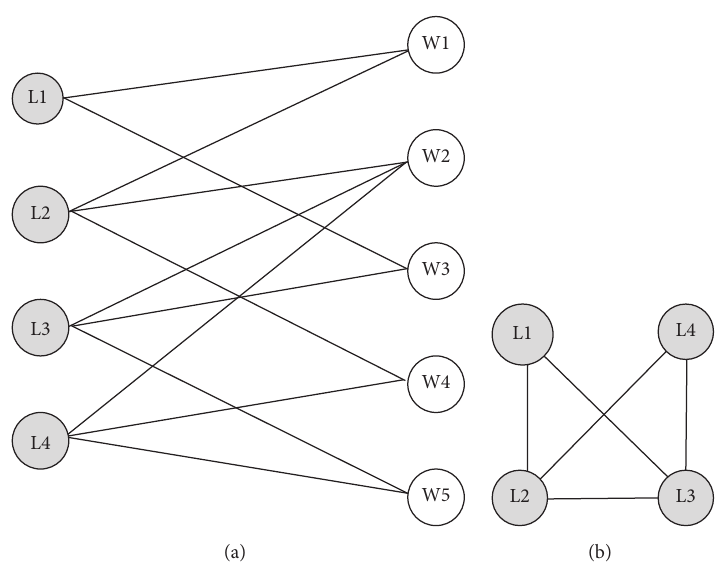
Figure 1: (a) Two-mode network of dengue affected localities and weeks. (b) The projected one-mode network of the two-mode dengue network shown in Figure